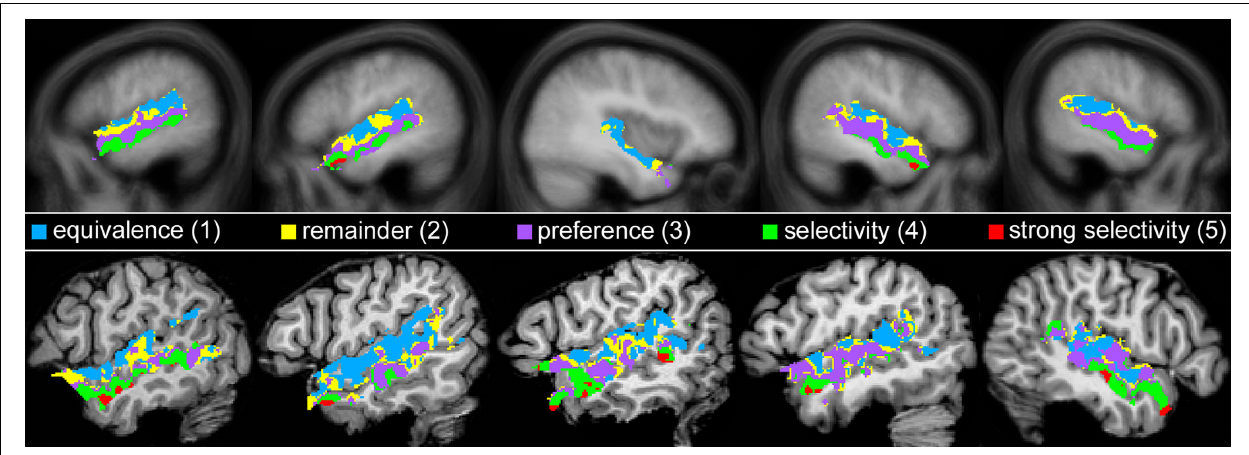
FIGURE 5 | Map of the areas in the temporal lobes that were significantly ( q FDR ≤ 0 . 05) activated by human voices (H + ) with each color representing a different activation pattern regarding voice processing (Nos. 1–5). For details see section Activation maps . Figure 6